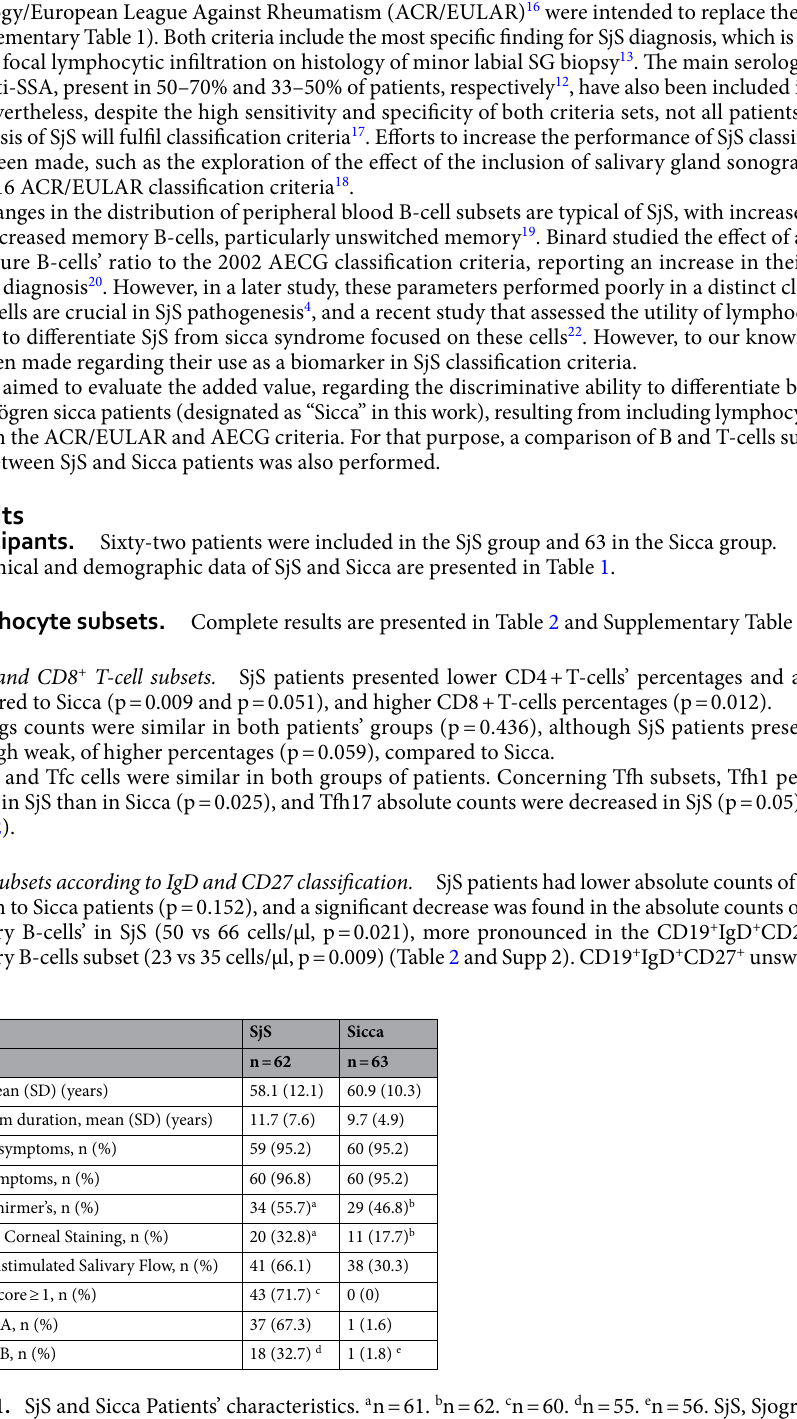
Table 1. SjS and Sicca Patients’ characteristics. a n = 61. b n = 62. c n = 60. d n = 55. e n = 56. SjS, Sjogren’s syndrome; SSA/SSB, Sjögren’s syndrome antigen A and B.